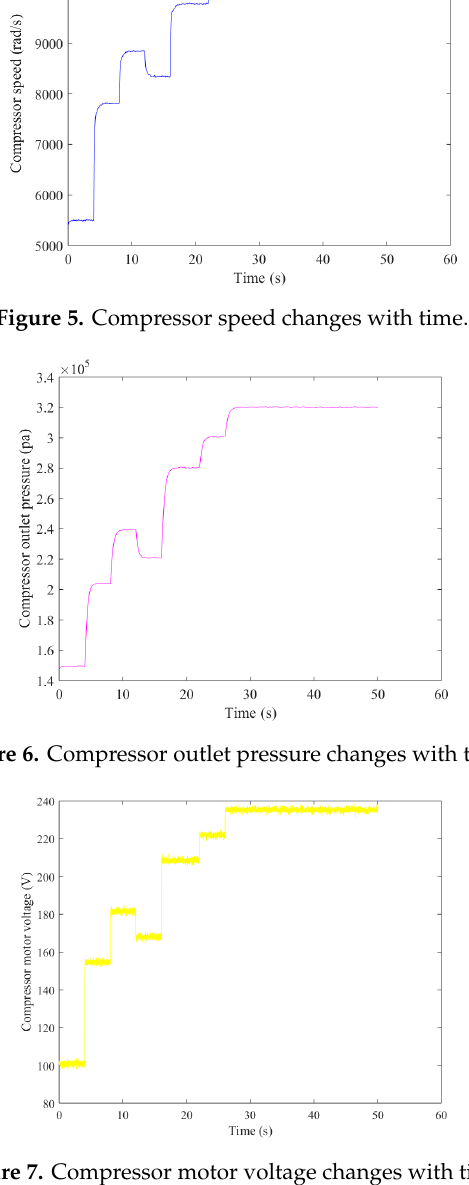
Figure 7. Compressor motor voltage changes with time.